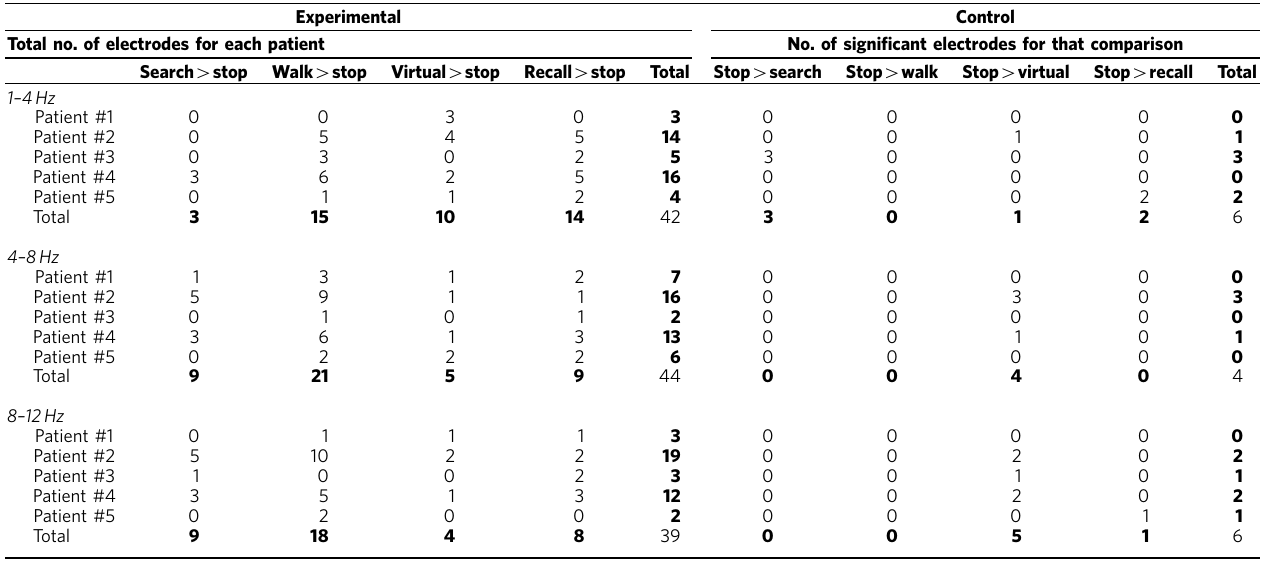
The P values are indicated in